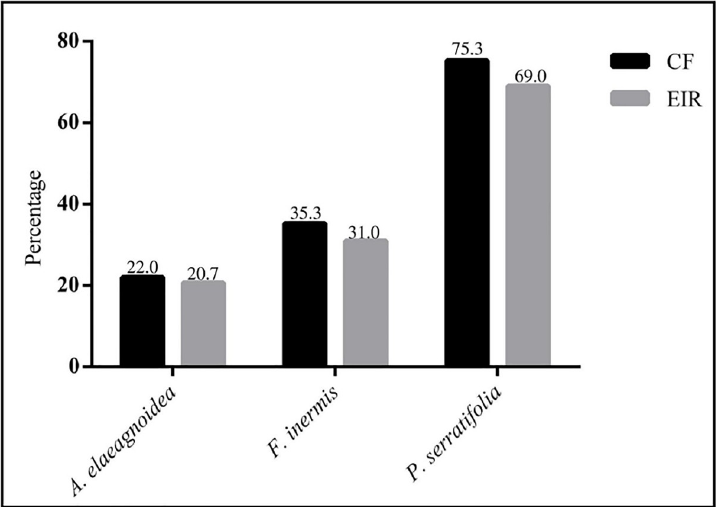
Fig 3. Colonization frequency (CF) and endophytic infection rate (EIR) of foliar endophytic fungi from three Magnoliopsida plants.